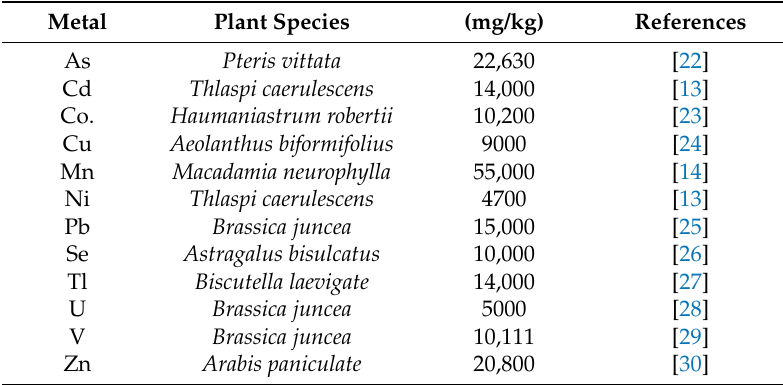
Table 1. Levels of metals recorded in hyperaccumulating